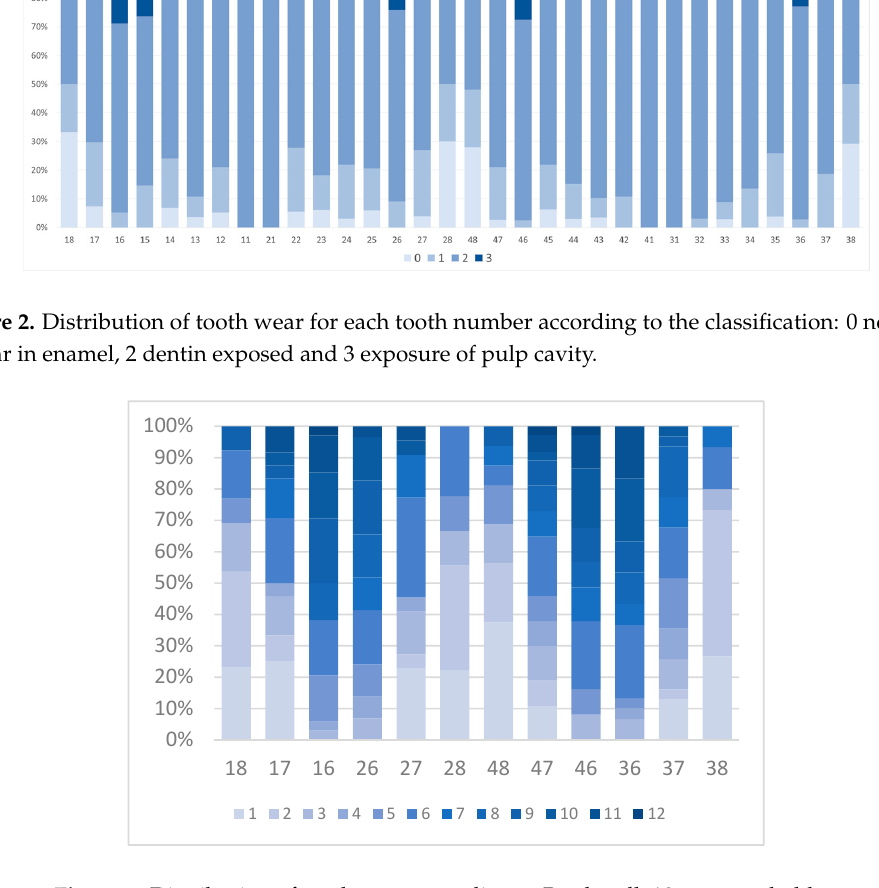
Figure 3. Distribution of tooth wear according to Brothwell, 18 years and older. Table 3. Tooth wear according to Brothwell modification, 18 years and older.